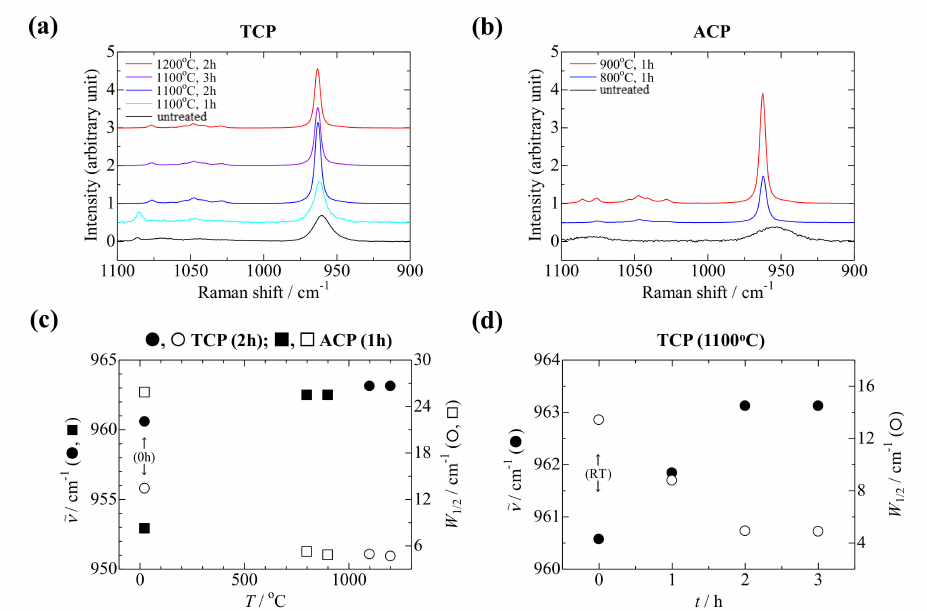
Figure 3. Raman spectra ( a , b ) and crystallinity analysis ( c , d ) of the sintered TCP and ACP shows that heat treatment not only promoted the formation of TCP and converted ACP into TCP but also increased crystal strength. The x -axis of the Raman spectra is the frequency of light measured in reciprocal centimeters; the y -axis is scattered